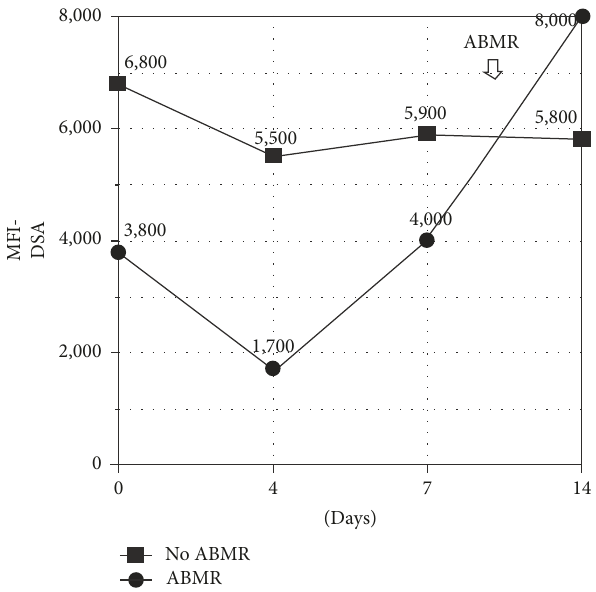
Figure 2: Mean iDSA-MFI in patients with and without ABMR over two